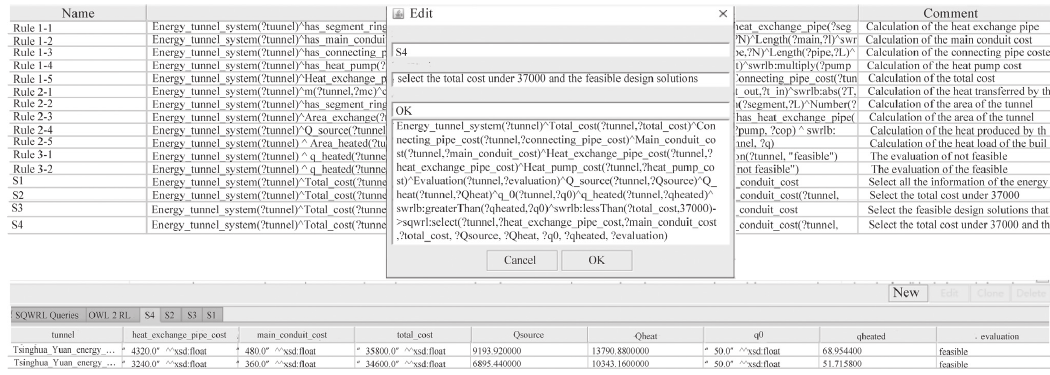
Figure 12: Execution and results of Table